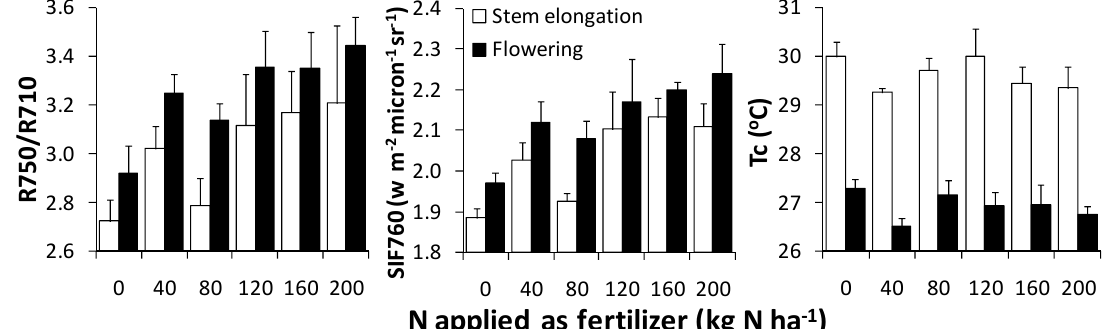
Figure 3. Relevant airborne indices at two different maize growth stages for the various N application treatments: the R750/R710 ratio obtained from the high-resolution hyperspectral imagery, solar-induced fluorescence (SIF760) and the temperature recorded with the thermal camera (Tc). Bars are the mean values for each treatment and error bars the standard